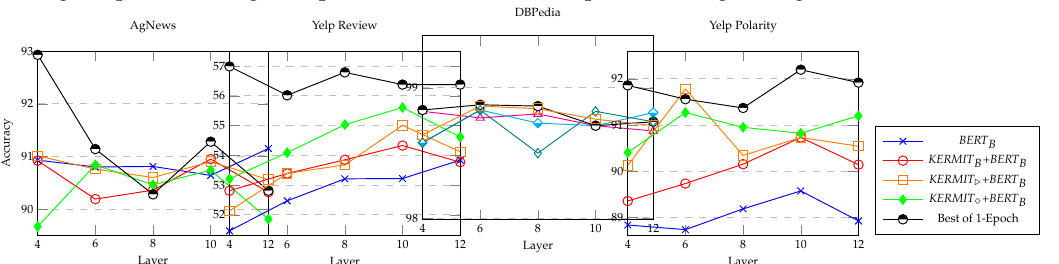
Figure 3. Comparison between KERMIT ./ Transformers and BERT when training layers in BERT L : Accuracy vs. Learned Layers in two different learning configurations—1-Epoch and 5-Epoch training